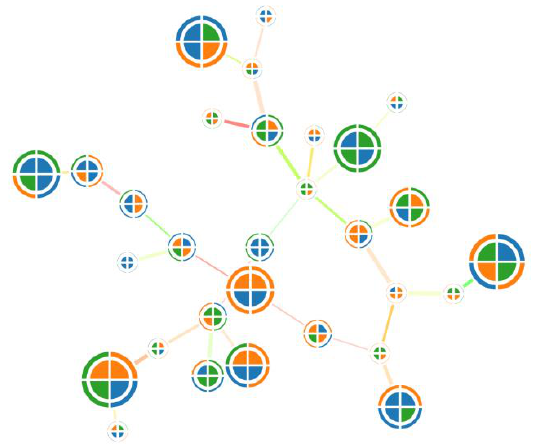
Figure 23. An example of a graph combined with glyphs. Due to glyphs, it becomes possible to use more object parameters.